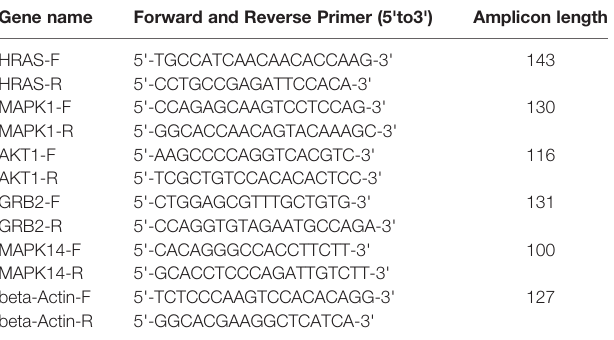
TABLE 1 | The nucleotide sequences of the primer pairs used for Quantitative gene